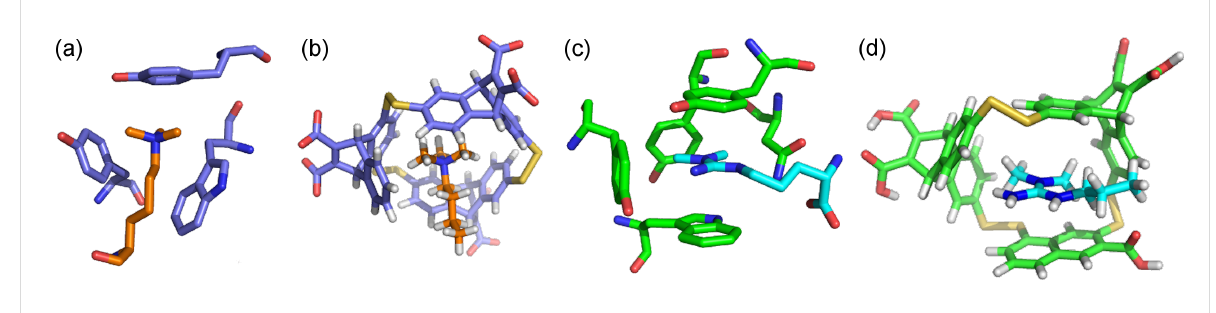
Figure 6: (a) Binding pocket of the Drosophila HP1 chromodomain (blue) bound to trimethyllysine (orange), PDB code: 1KNE [39]. (b) Computational model of a synthetic receptor, A 2 N (blue), bound to KMe3 (orange) [40] (c) Binding pocket of the SMN tudor domain (green) bound to asymmetric dimethylarginine (aDMA, cyan). (d) Computational model of a synthetic receptor, A 2 D (green), bound to aDMA (cyan) [41].